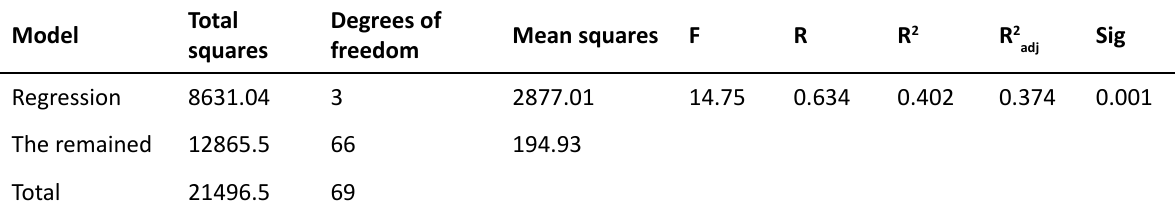
Table 4. Standard and non-standard coefficients and inserted t-statistic in the regression model